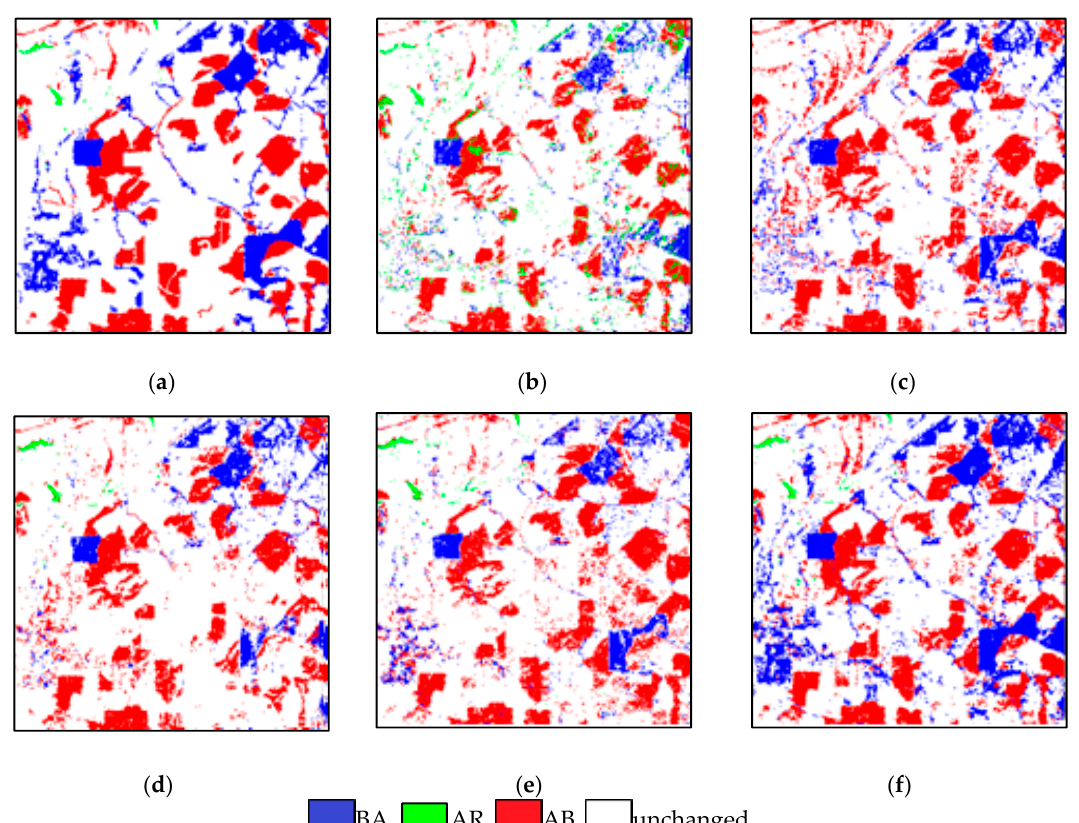
Figure 11. The abundances in the entire image: ( a ) bare soil (B), ( b ) rivulet (R), ( c ) agricultural crop (A), ( d ) agricultural crop–rivulet (AR), ( e ) agricultural crop–bare soil (AB) and ( f ) bare soil– agricultural crop (BA).